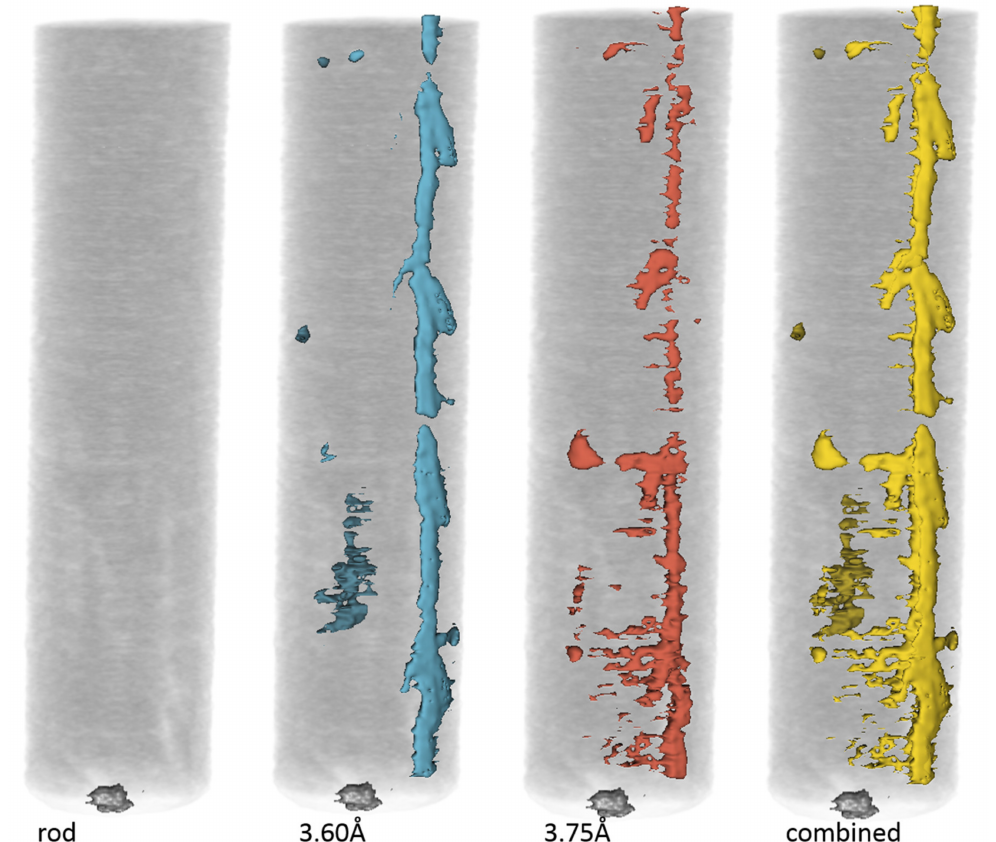
Figure 4. 3D view and segmentation. The volume of the copper rod (left in the figure) is shown in transparency through the 3D Slicer’s Volume Rendering module, and then used as a spatial reference for the next three images: for both λ 3.60 Å and λ 3.75 Å the two dendritic branches are enhanced by segmentation and highlighted respectively in blue and orange; the combined structure consisting of the two branches is represented in